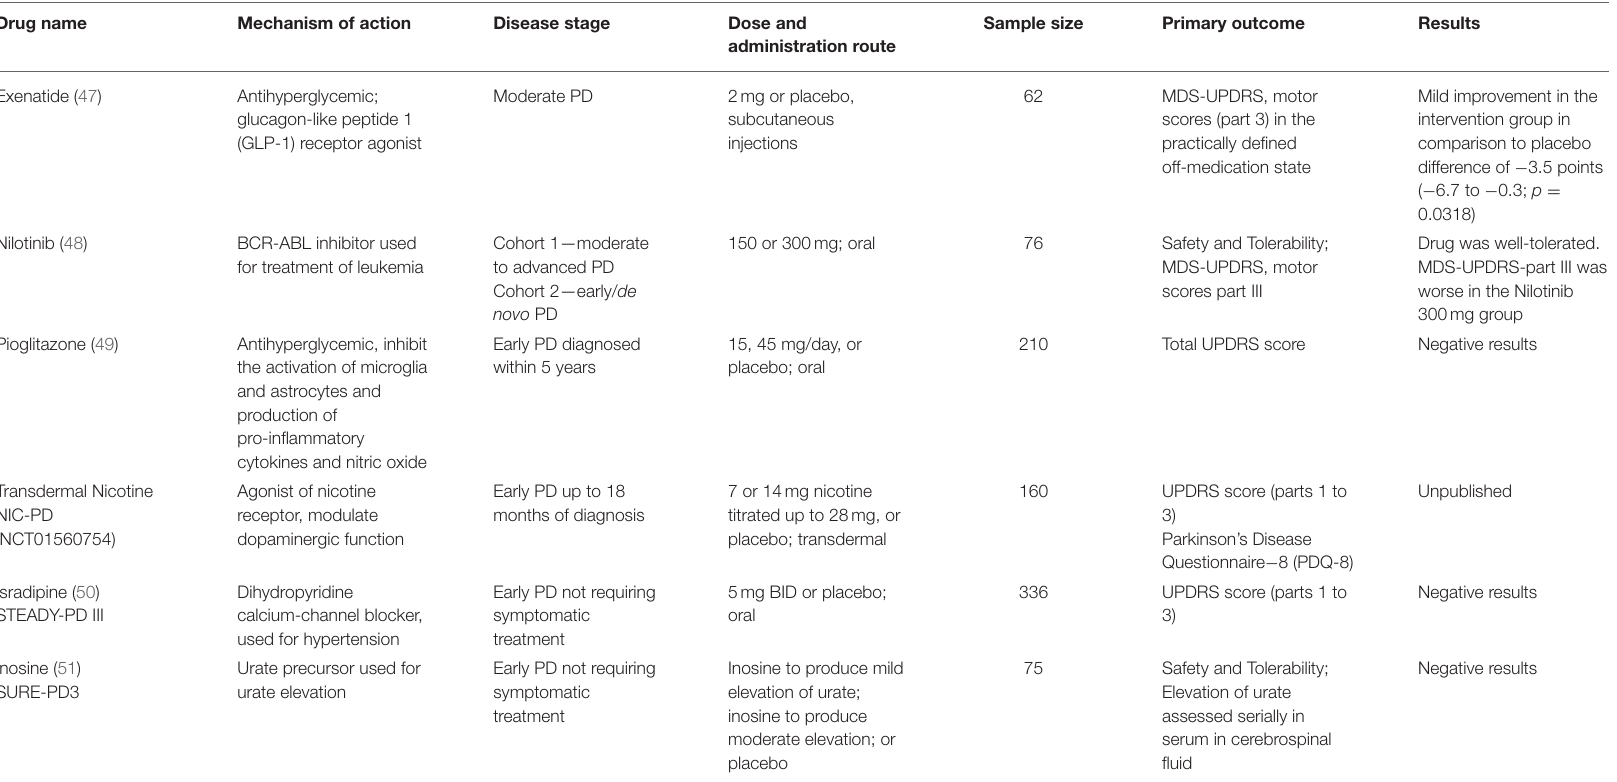
TABLE 2 | Recent clinical trials for disease-modification in PD.